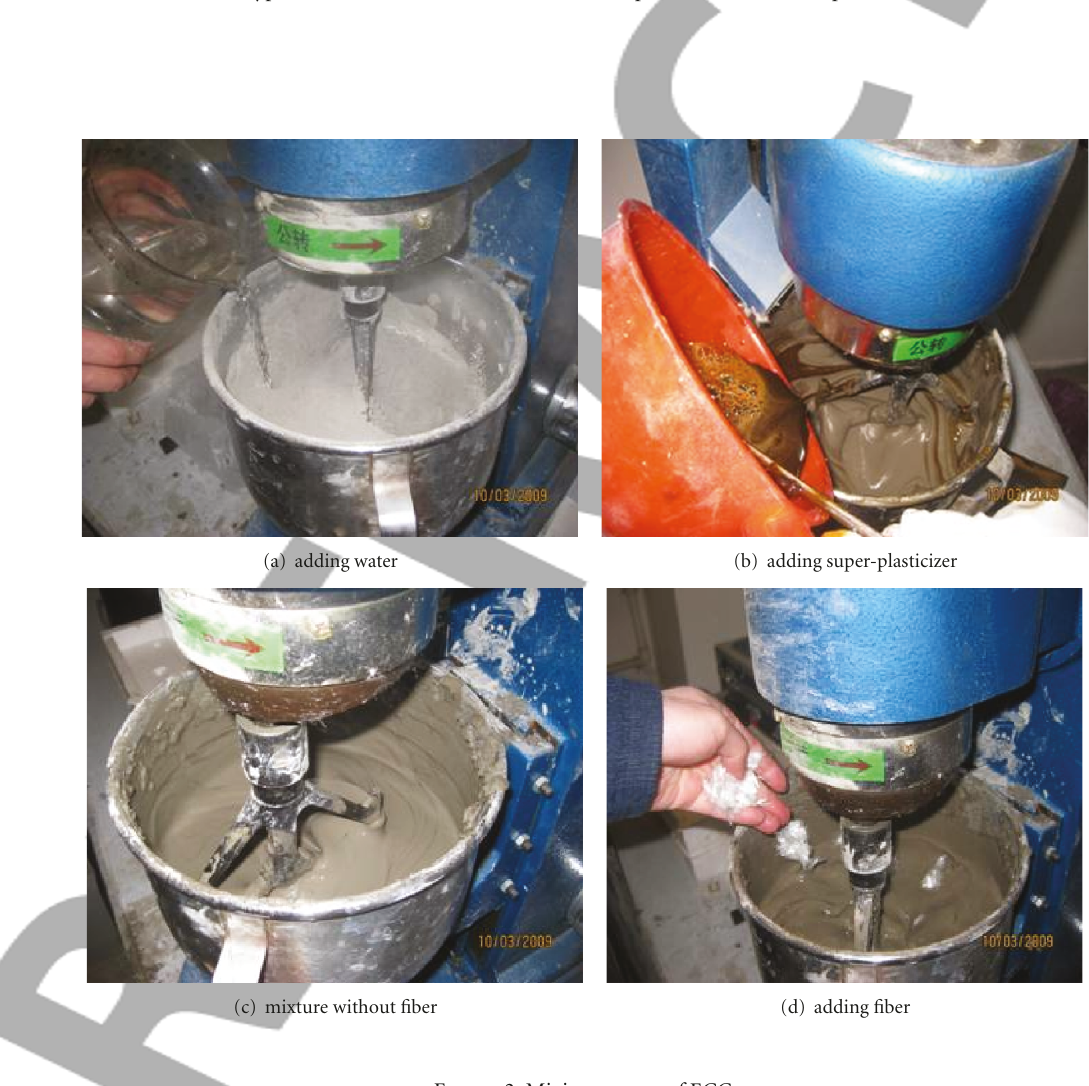
Figure 2: Mixing process of